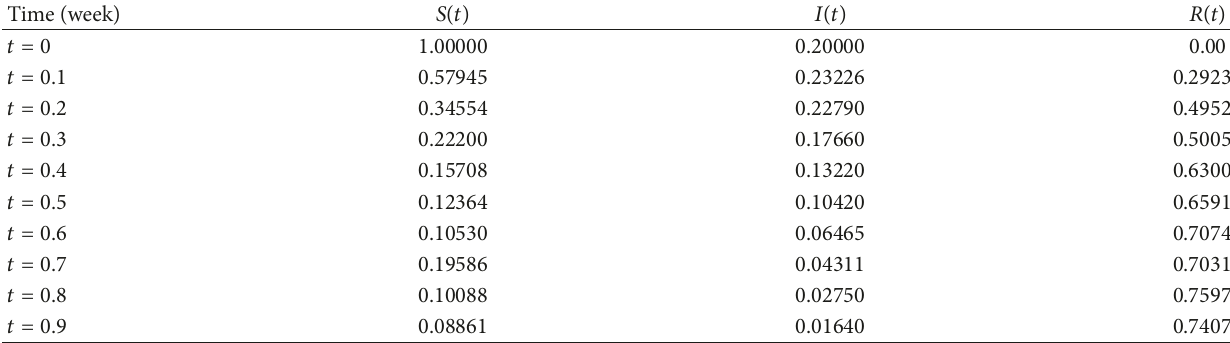
Table 1: Numerical solution of the proposed model using LADM at classical order 𝛼 = 1 .